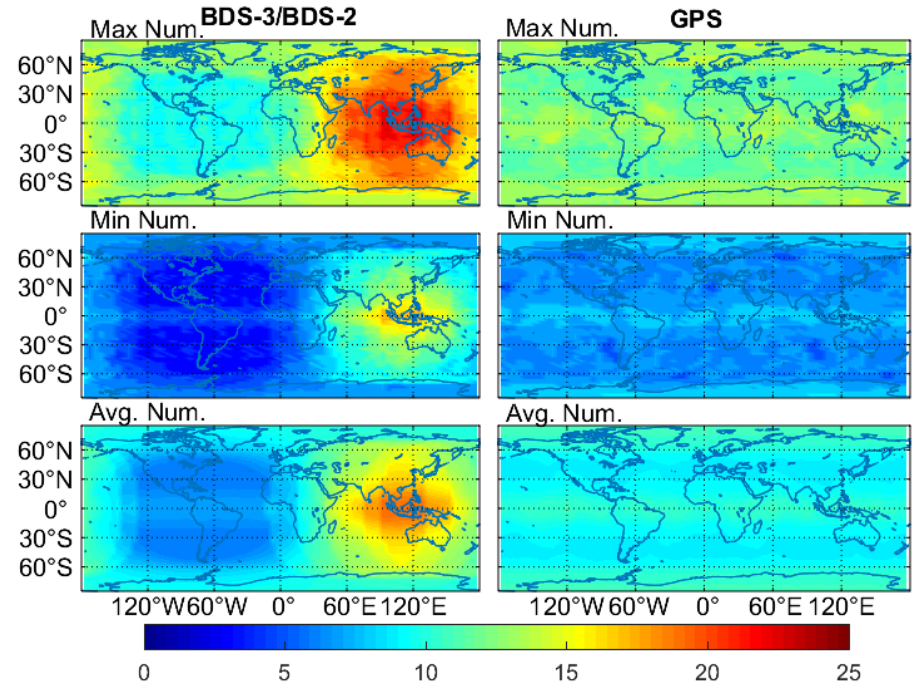
Figure 3. Global maps of the maximum, minimum and average number of visible satellites of GPS and BDS-3/BDS-2 on DOY 140–146 of 2020 (note that a visible satellite has an elevation angle higher than 7°).